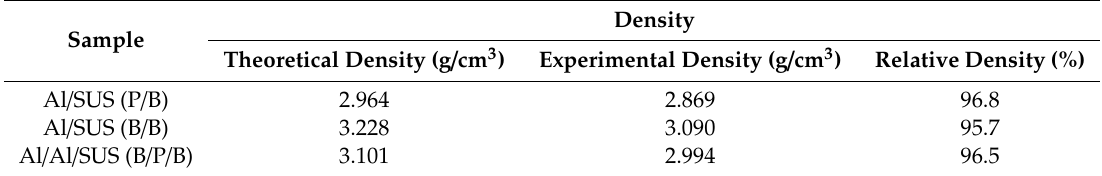
Figure 3. Energy dispersive X-ray spectroscopy (EDS) line scans of Al / SUS: ( a ) P / B, ( b ) B / B, and ( c ) B / P / B clads. Table 1. Densities and thermal properties of Al / SUS clads.